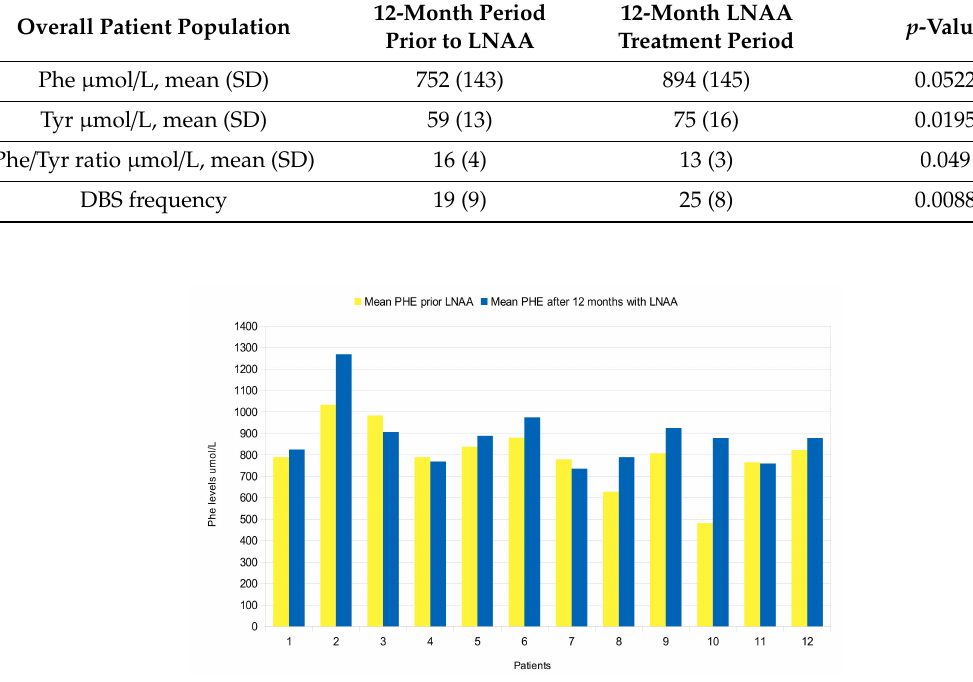
Figure 1. Mean Phe levels 12 months prior and after LNAA introduction for each patient.